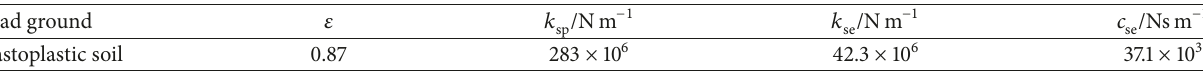
Table 6: The parameters of an elastoplastic ground deformation with a high density soil.